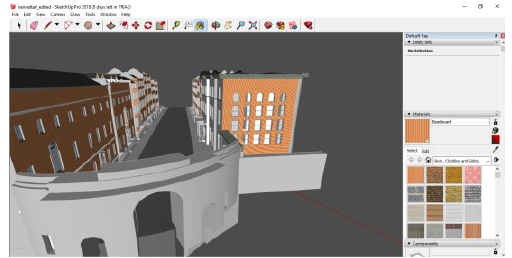
Figure 8: SketchUp model with materials